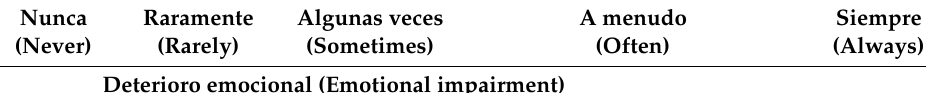
Table A1. Cont. Nunca Raramente Algunas veces (Never) (Rarely) (Sometimes) (Always) Deterioro emocional (Emotional impairment) En mi trabajo, me siento incapaz de controlar mis emociones. (At